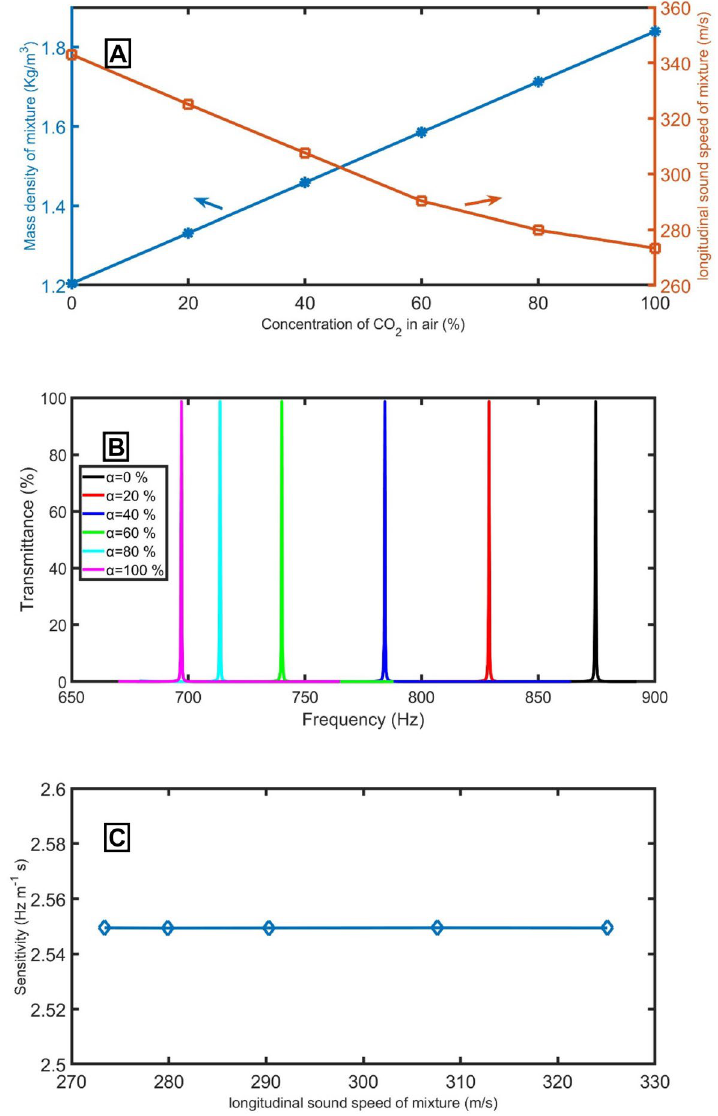
Figure 11. ( A ) the mass density of the mixture and longitudinal sound speed of the mixture versus the concentration of CO 2 , ( B ) the transmittance of different ratios of CO 2 in the air at the optimum conditions, and ( C ) the sensitivity versus the acoustic velocity at different